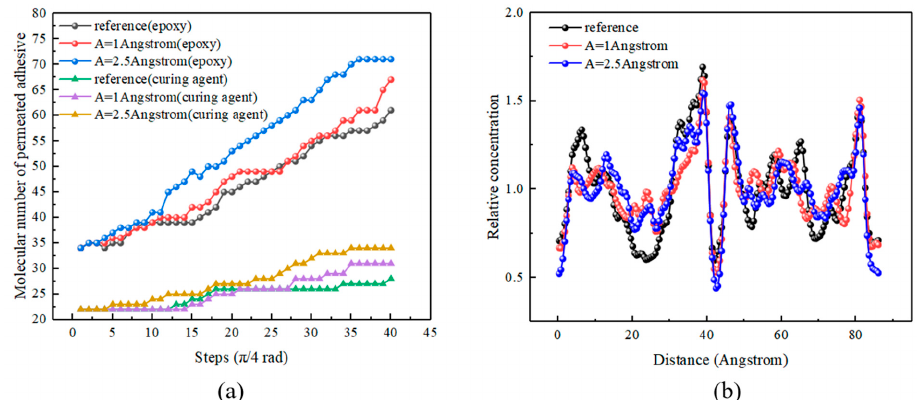
Figure 14. Molecular numbers of permeated adhesive ( a ) and concentration profiles ( b ) of the final states of the simulations with different amplitudes. Table 8. Variances of concentration with different amplitudes.